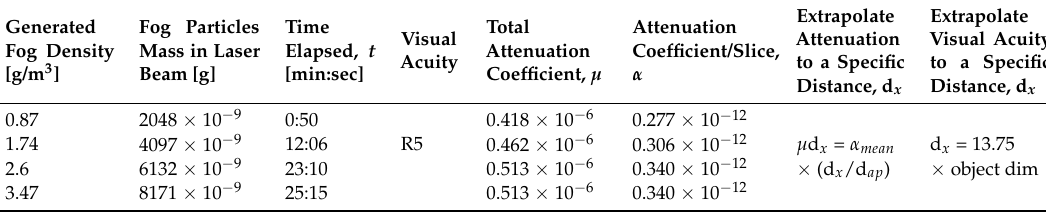
Table 2. Estimating visual acuity based on attenuation coefficient.